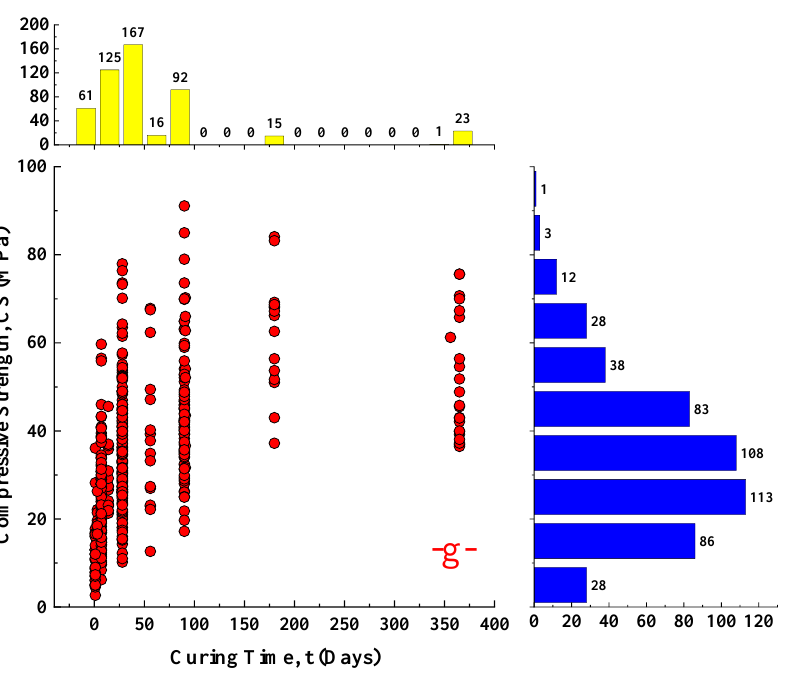
Figure 2. Marginal plot for compression strength with ( a ) w/c, ( b ) cement content, ( c ) gravel content, ( d ) sand content, ( e ) fly ash content, ( f ) superplasticizer content, and ( g ) curing time.